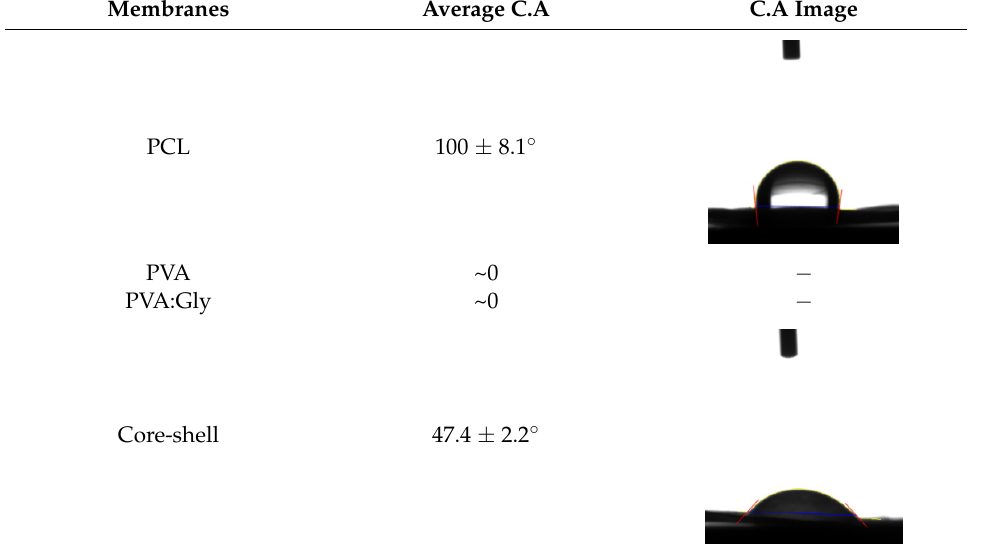
Table 4. The average contact angles and contact-angle images of the fabricated membranes.